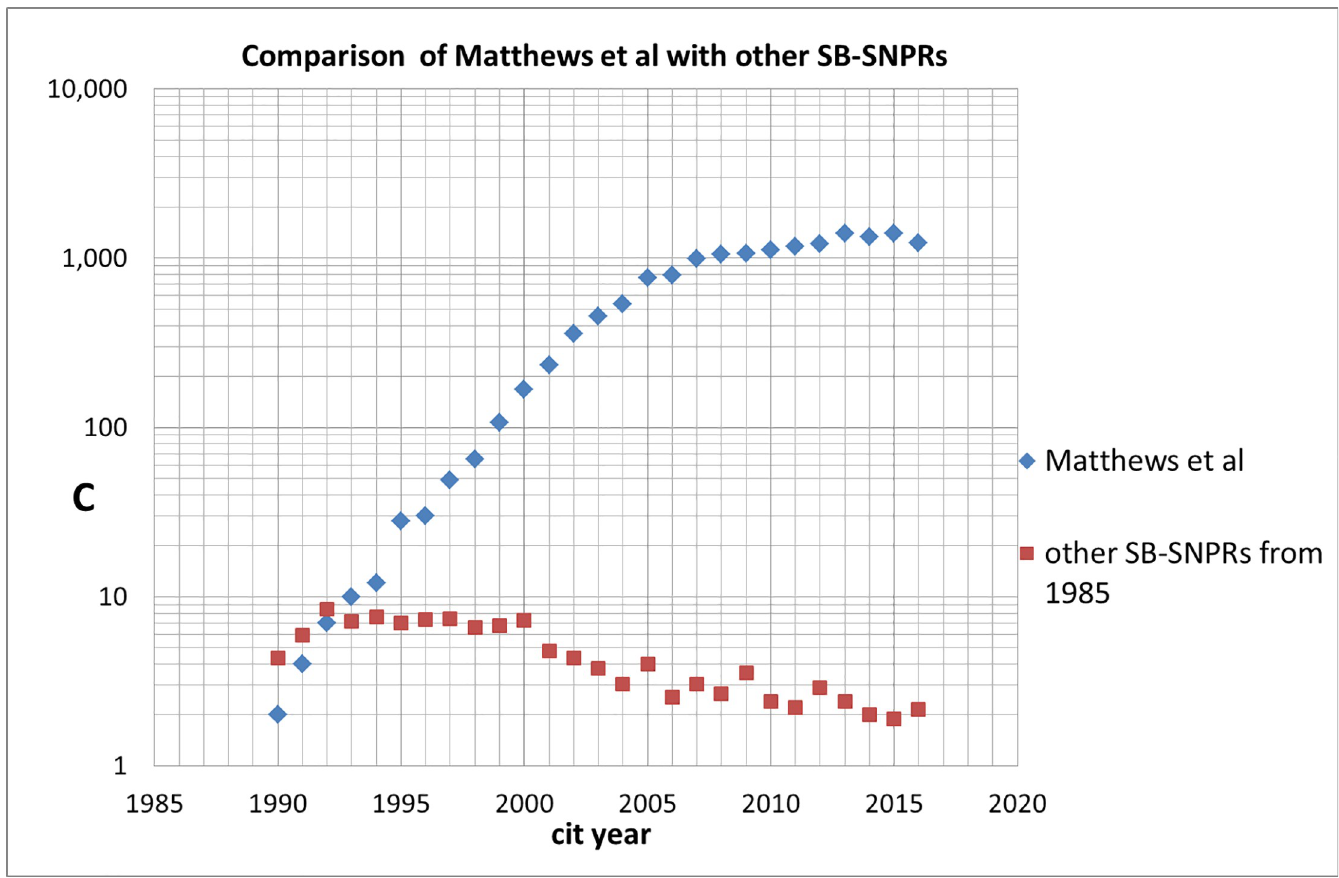
Fig 24. Trend in the number of citations received by the Matthews et al [24] compared to the average of the other SB-SNPRs published in 1985. On the abscissa the years of citation are given, on the ordinate the number of